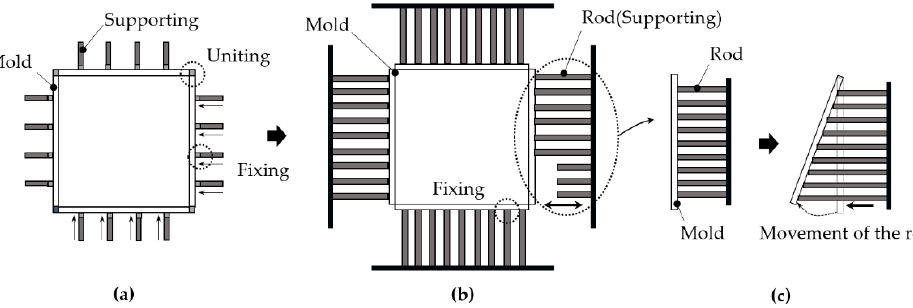
Figure 4. Applying the concept of rod: ( a ) Conventional mold; ( b ) Applying the concept of rod to mold; ( c ) Rotating the mold by the movement of the rod.